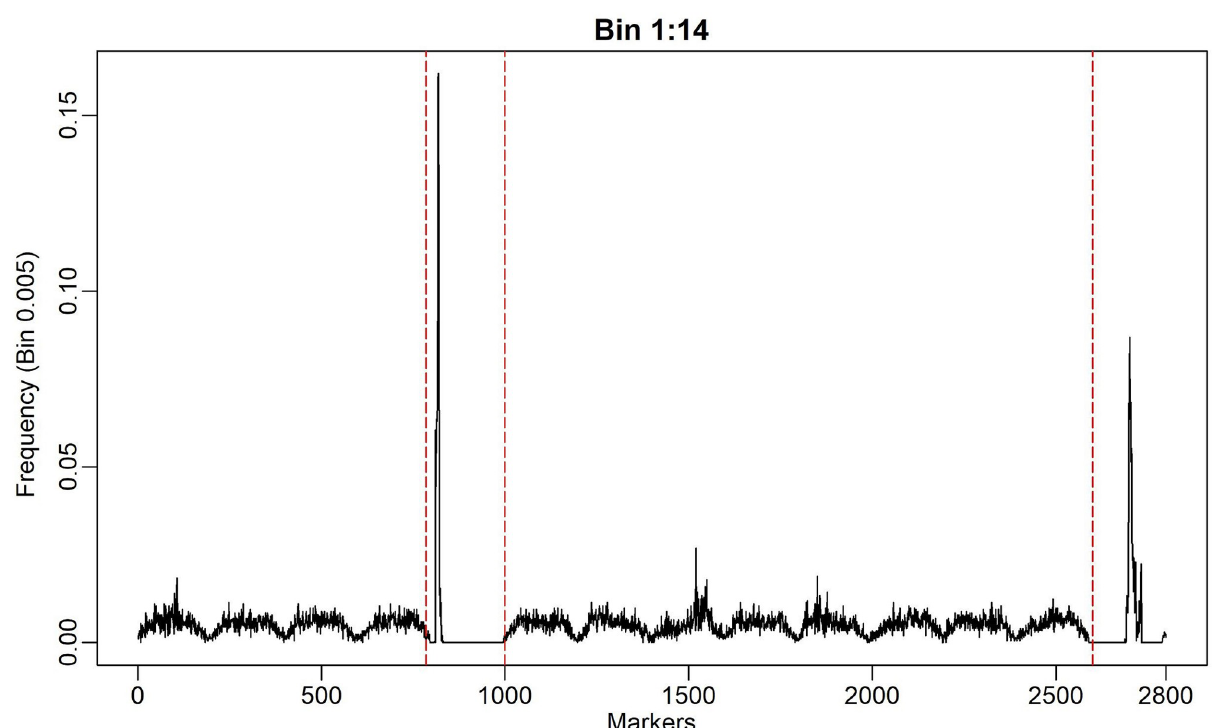
Fig 5. Relative frequency for the first 14 bins (Bins 1:14) of the Bin 0.005 model for the heritability level of 0.8. The dashed lines represent the possible natural bins that can be established instead of the first 14 bins, which are fixed a priori, with the Bin 0.005 model.